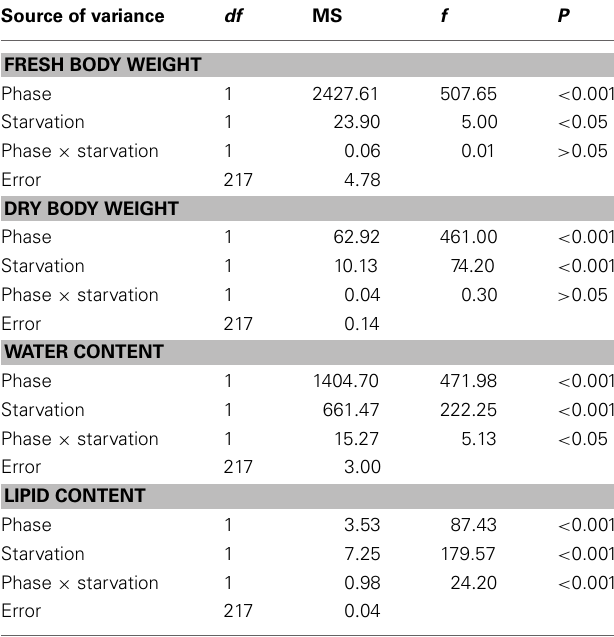
Table 2 | Two way analysis of variance for fresh body weight (mg), water contents (mg), dry body weight (mg) and lipid contents (mg) for Schistocerca gregaria hatchlings from either isolated-reared (solitarious) or crowd-reared (gregarious)